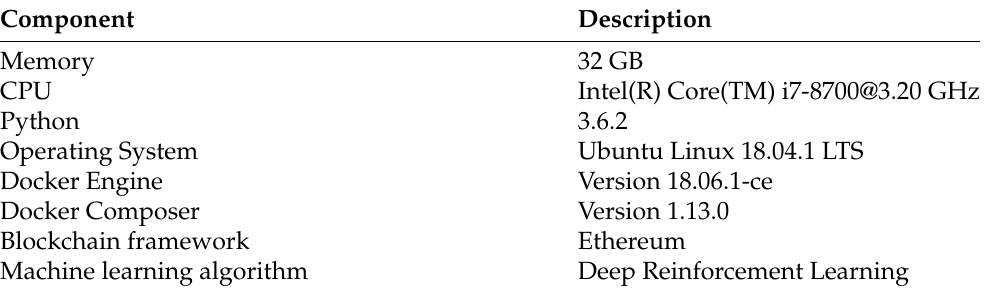
Table 3. Development environment of the proposed